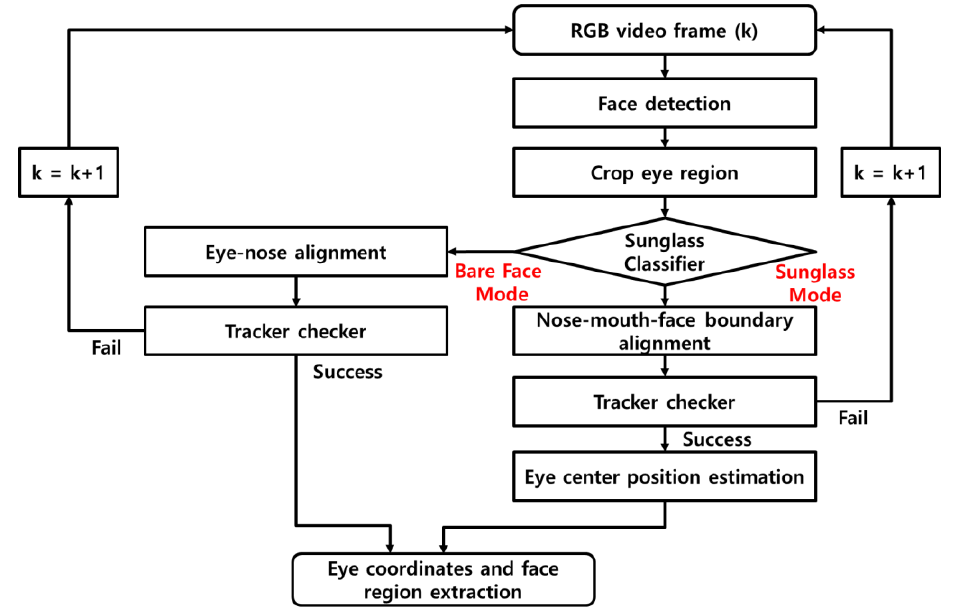
Figure 2. Flowchart of the proposed eye-tracking method for bare and sunglasses-wearing faces.